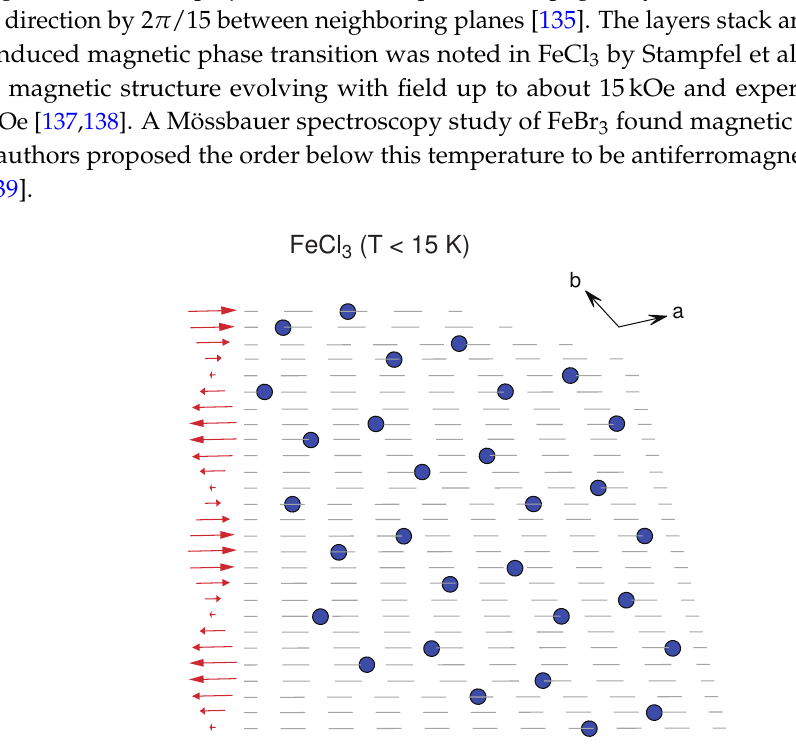
Figure 9. The helimagnetic structure of FeCl 3 . A portion of one layer of Fe atoms is shown, along with the hexagonal coordinate system. The dotted lines indicate (140) planes. The moment of the atoms lying on these planes is indicated by the red arrows at the left of each line. Moments are in the (140) planes and have components in and out of the